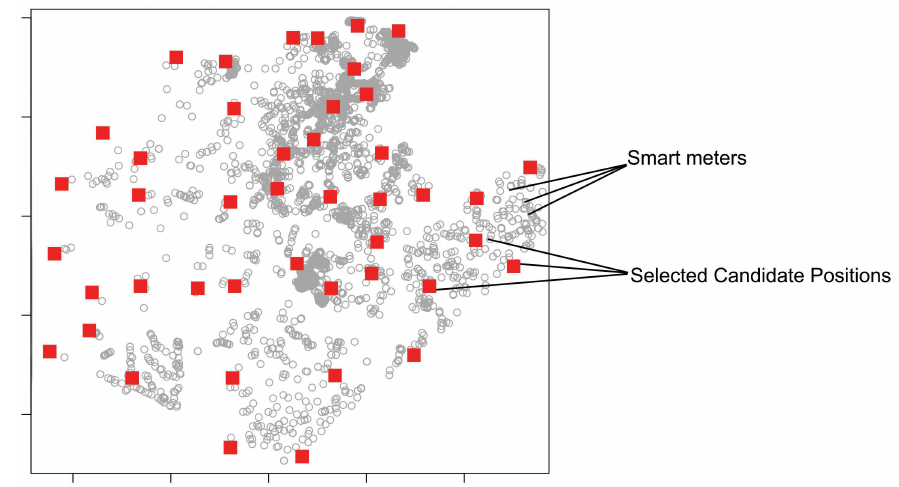
Figure 5. Selected Candidate Positions.